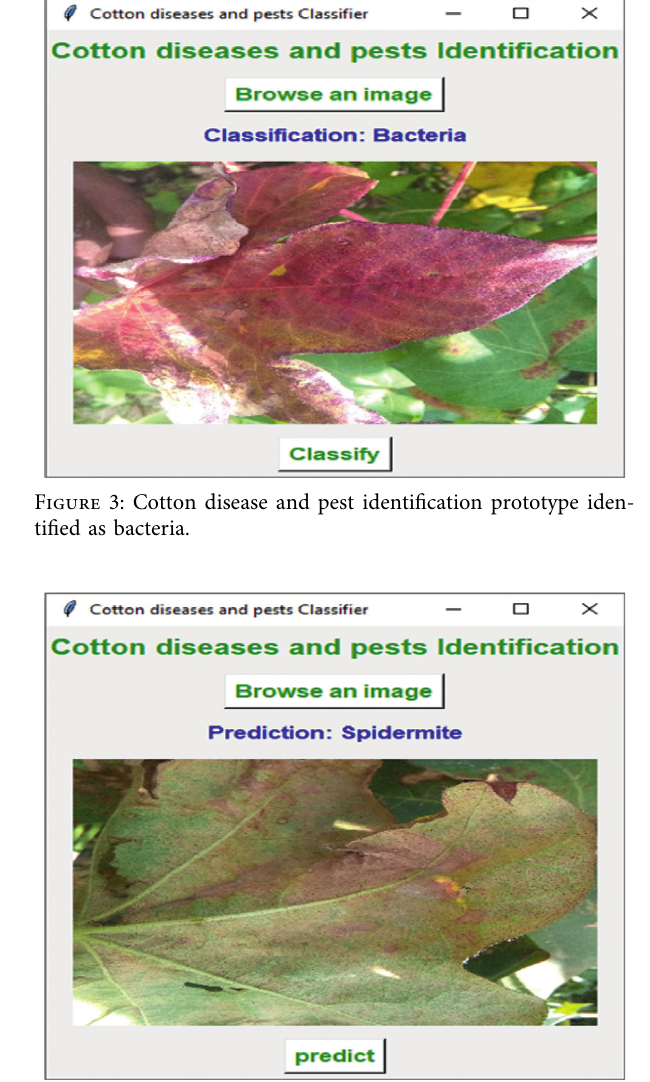
Figure 4: Cotton disease and pest identification prototype iden- tified as spider